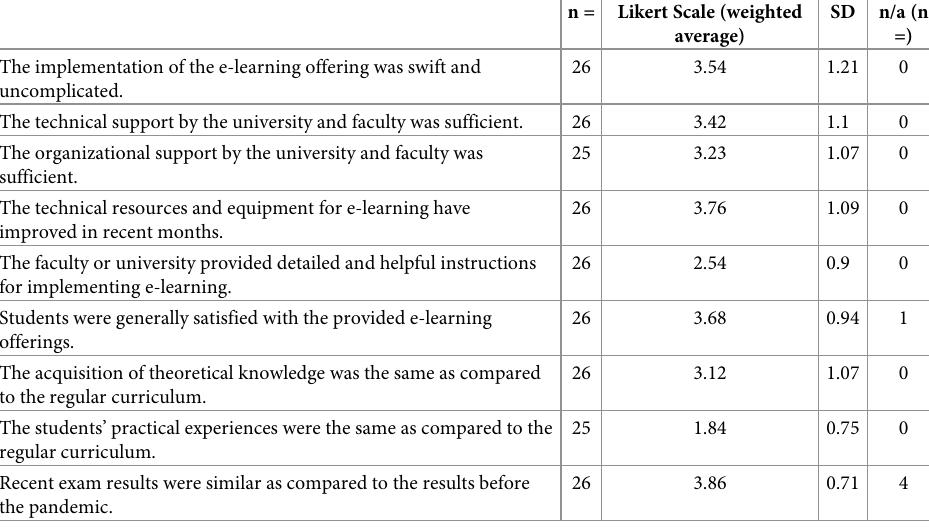
n = Likert Scale (weighted SD n/a (n average) =)